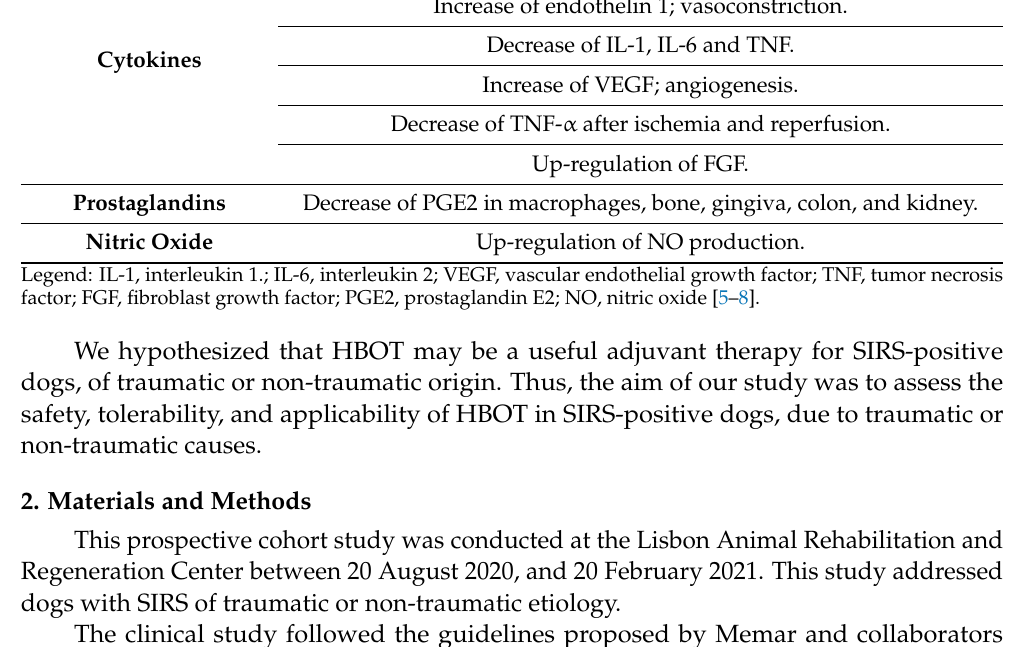
Table 1. Hyperbaric oxygen therapy main effects. Increase of endothelin 1; vasoconstriction. Decrease of IL-1, IL-6 and TNF. Cytokines Increase of VEGF; angiogenesis. Decrease of TNF- α after ischemia and reperfusion. Up-regulation of FGF. Prostaglandins Decrease of PGE2 in macrophages, bone, gingiva, colon, and kidney. Nitric Oxide Up-regulation of NO